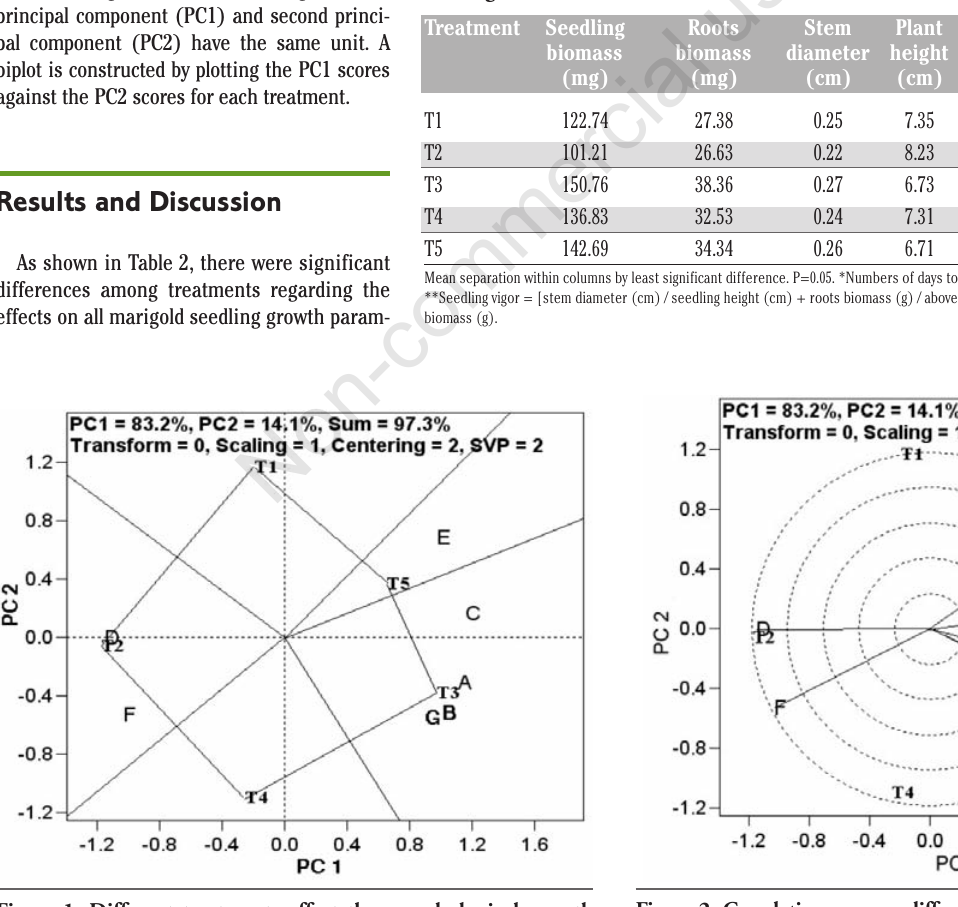
Figure 1. Different treatments affect the morphological growth parameters of marigold seedling. A, seedling biomass; B, root biomass; C, stem diameter; D, plant height; E, leaf area; F, days taken to start blooming; G, seedling vigor.